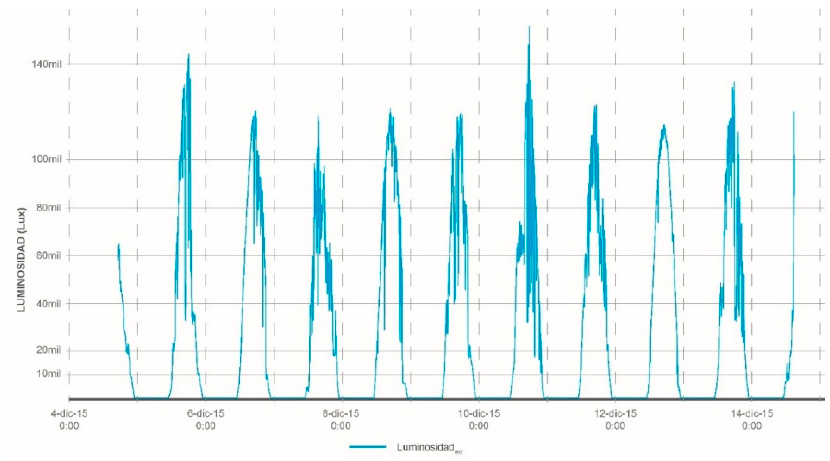
Figure 6. Lighting data in Santiago de Cali, December 4 − 15. Source: Solar Decathlon staff.